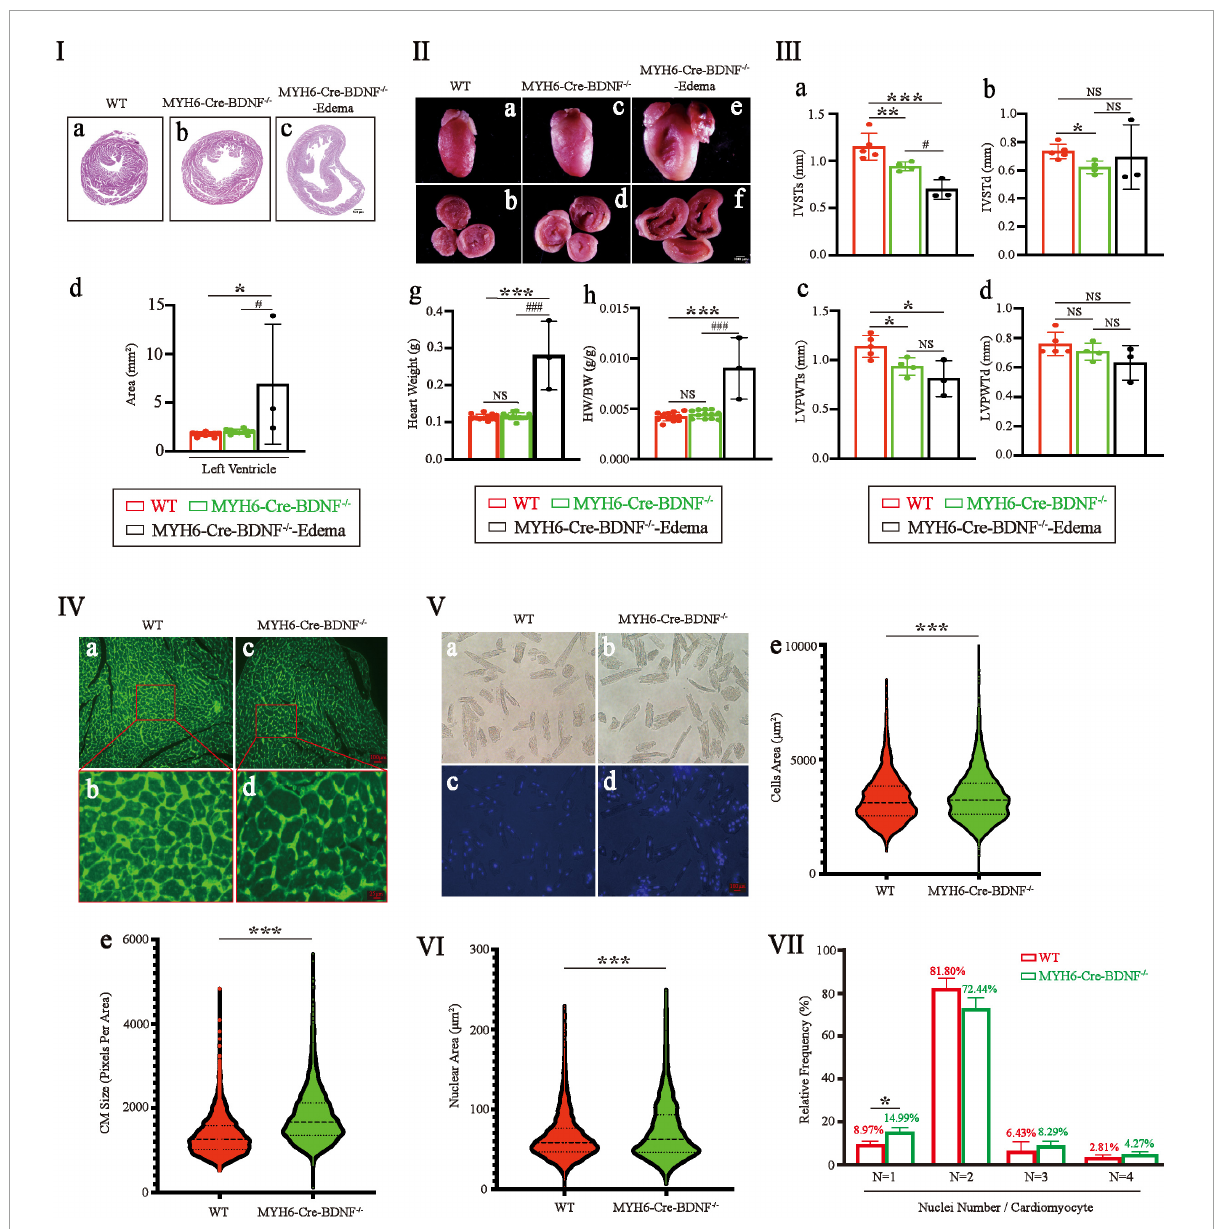
FIGURE3 Eccentric myocardial hypertrophy accompanied by an increase in the area of the cardiomyocyte nucleus and an increase in the percentage of single-nucleus cardiomyocytes were found in young adult MYH6-Cre-BDNF − / − mice: (I,II) The left ventricular area of 3-month-old MYH6-Cre-BDNF − / − male hearts was significantly larger than that of WT hearts (I) . In addition, the ventricular area, heart weight and ratio of heart weight/body weight of 3-month-old MYH6-Cre-BDNF − / − osmotic edema mice were significantly higher than those of 3-month-old MYH6-Cre-BDNF − / − and WT mice (I,II) . n = 10 for the 3-month-old male WT and MYH6-Cre-BDNF − / − groups respectively; n = 3 for the 3-month-old male MYH6-Cre-BDNF − / − edema group. (III) Echocardiography showed that the interventricular septum end-systolic thickness (IVSTs) and left ventricular posterior wall end-systolic thickness (LVPWTs) of 3-month-old MYH6-Cre-BDNF − / − hearts were significantly smaller than those of WT hearts (a,c) . In addition, the IVSTs of 3-month-old MYH6-Cre-BDNF − / − osmotic edema hearts was significantly smaller than those of 3-month-old MYH6-Cre-BDNF − / − hearts and WT hearts (c) . Furthermore, the interventricular septum end-diastolic thickness (IVSTd) of 3-month-old MYH6-Cre-BDNF − / − hearts was significantly smaller than that of WT hearts (b) . n = 5 and 4 for the 3-month-old male WT and MYH6-Cre-BDNF − / − groups respectively; n = 3 for the 3-month-old male MYH6-Cre-BDNF − / − edema group. (IV) Semiquantification of WGA immunofluorescence staining revealed that the mean area of cardiomyocytes in 3-month-old MYH6-Cre-BDNF − / − hearts was significantly higher than that in WT hearts. n = 6. (V) Quantification analysis of isolated single cardiomyocytes demonstrated that the mean area of cardiomyocytes in 3-month-old MYH6-Cre-BDNF − / − hearts was significantly higher than that in WT hearts. n = 3. (VI) The mean area of cardiomyocyte nuclei of 3-month-old MYH6-Cre-BDNF − / − hearts was significantly higher than that of WT hearts. n = 3. (VII) The percentage of single-nucleus cardiomyocytes in 3-month-old MYH6-Cre-BDNF − / − hearts (N: Number of nuclei per cell) was significantly higher than that in WT hearts, n = 3. *, # p < 0.05, ** p < 0.01, ***, ### p <